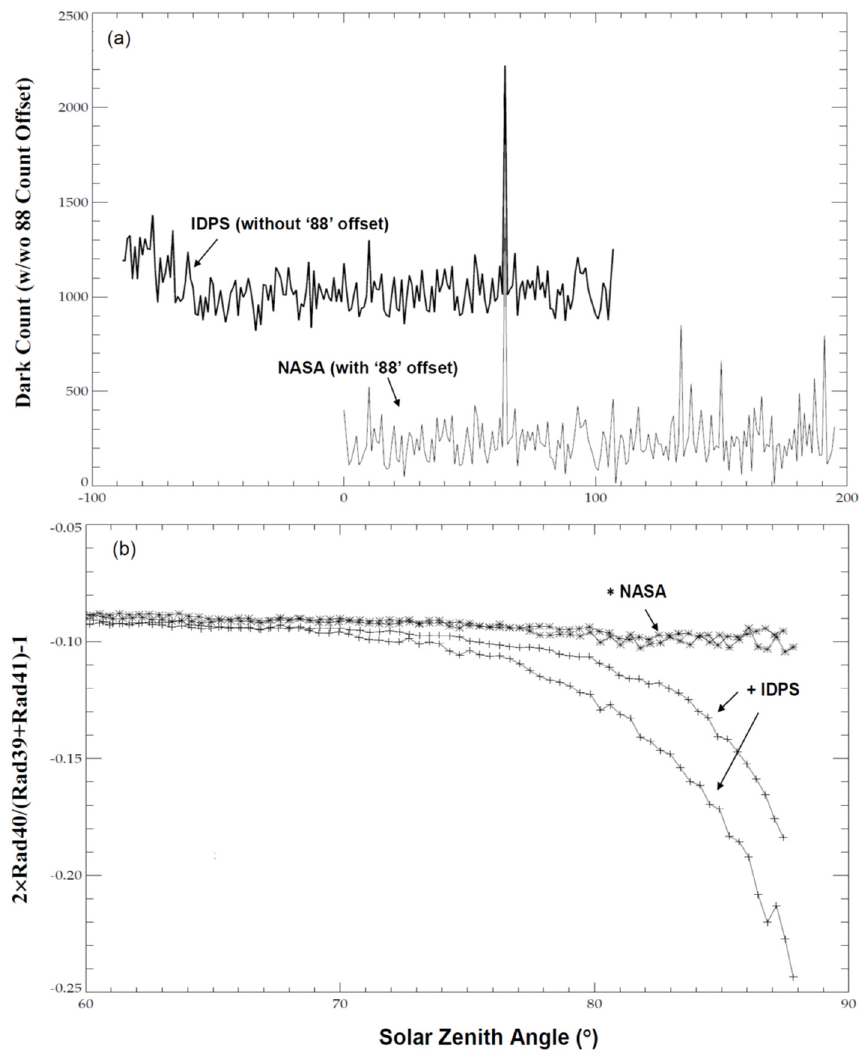
Figure 4. ( a ) Comparison of SNPP OMPS NM dark corrections between the NASA (offset = 88) and the IDPS processing (offset = 0). ( b ) Centered difference for the radiances at the 41st wavelength (Rad41 in the figure; approximately corresponding to 317 nm), relative to those at the 40th and 42nd wavelength (Rad40 and Rad42) for the third cross-track position. More discussions are referred to [34].